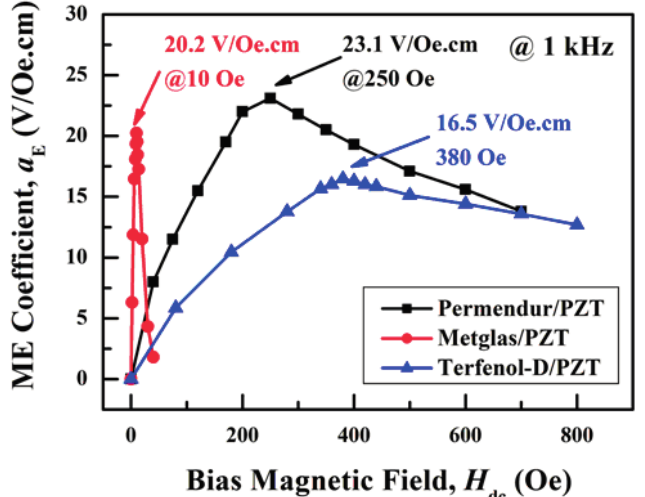
Figure 1. Magneto-electric (ME) coefficient versus bias magnetic field for the Permendur/PZT, Metglas/PZT, and Terfenol-D/PZT laminated composites (with the same dimension and structure) at a frequency of ~1 kHz,